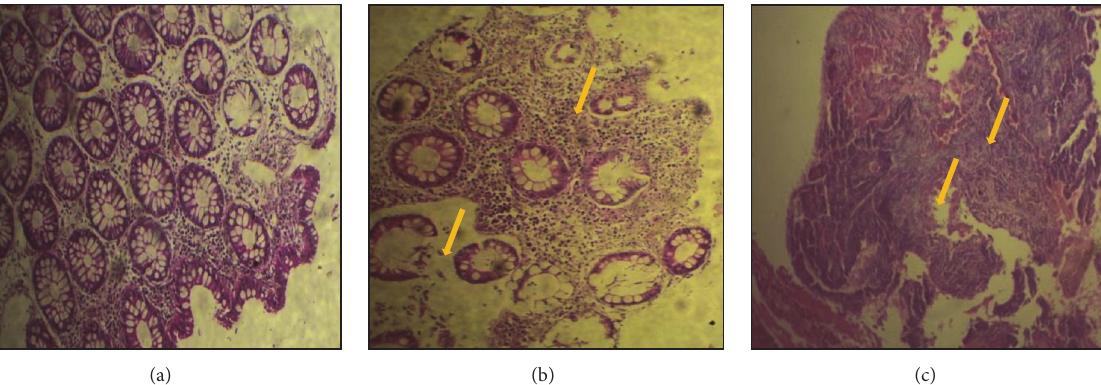
Figure 4: Representative photomicrographs of H&E-stained (a) colonic mucosa from control, (b) active UC patients (severe inflammation; higher score 5.4), and (c) CAC patients (severe inflammation; higher score 5.4). Arrows show cellular infiltrate and crypt destruction (UC, ulcerative colitis, 𝑛 = 10 ; CAC, colitis associated cancer, 𝑛 = 9 ; C, control, 𝑛 = 5